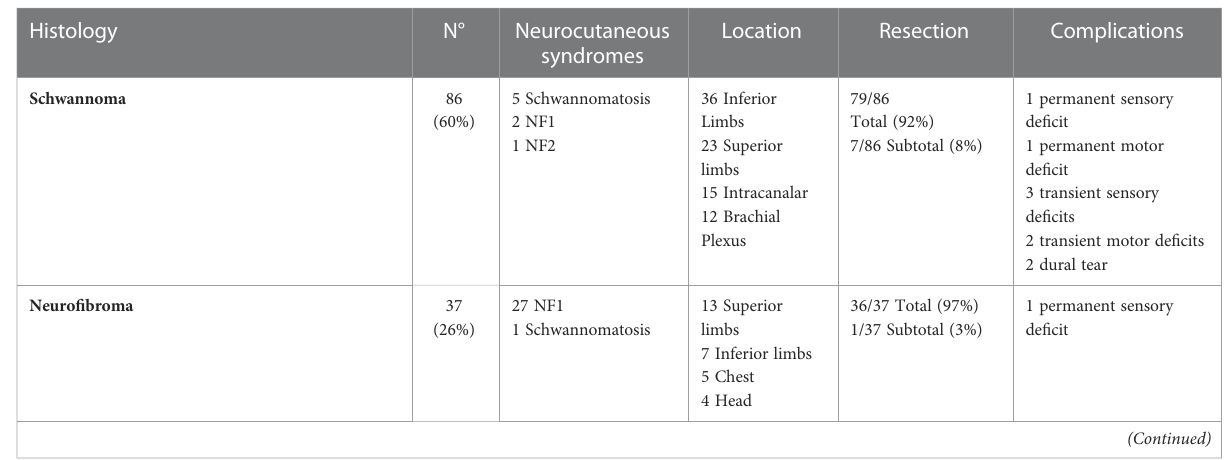
TABLE 2 Clinical characteristics of the comparison historical cohort of